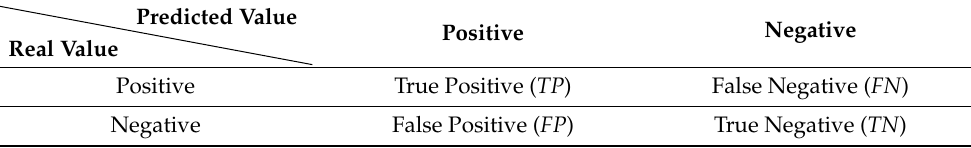
Table 3. Division of positive and negative samples.